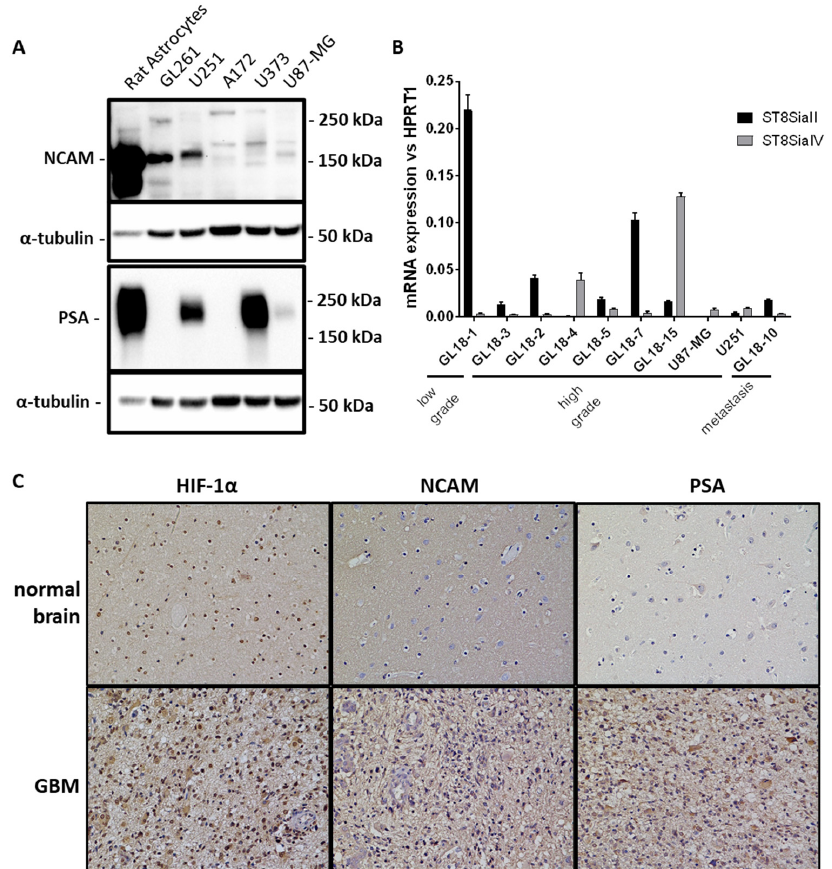
Figure 1. NCAM and PSA expression in different GBM cell cultures and hypoxic areas of GBM tissues. ( A ) Western blot qualitative analysis showing NCAM isoforms and PSA expression levels in a mouse glioma cell line (GL261) and four human GBM cell lines (U251, A172, U373, U87-MG) compared to normal neonatal rat astrocytes, included as positive control. ( B ) Real-time PCR analysis showing mRNA expression of polysialyltransferases II and IV (ST8SiaII and ST8SiaIV) in low grade (GL18-1 and GL18-3) and high grade (GL18-2, GL18-4, GL18-5, GL18-7, GL18-15) glioma patient- derived primary cultures compared to U87-MG and U251 GBM cell lines and a brain metastasis. ( C ) Immunohistochemical analysis showing the expression of NCAM, PSA and HIF-1 α in formalin- fixed, paraffin embedded sections of a GBM tissue compared to a normal, non-tumoral brain.